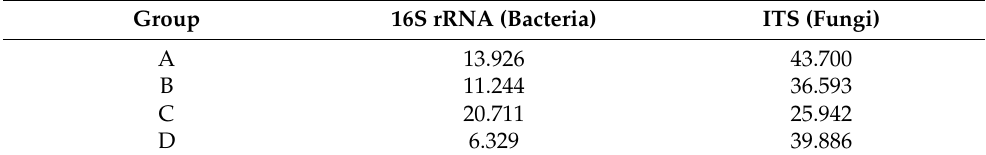
Table 2. Average variability of taxa in the four sample groups (A–D) based on 16S rRNA and ITS region.